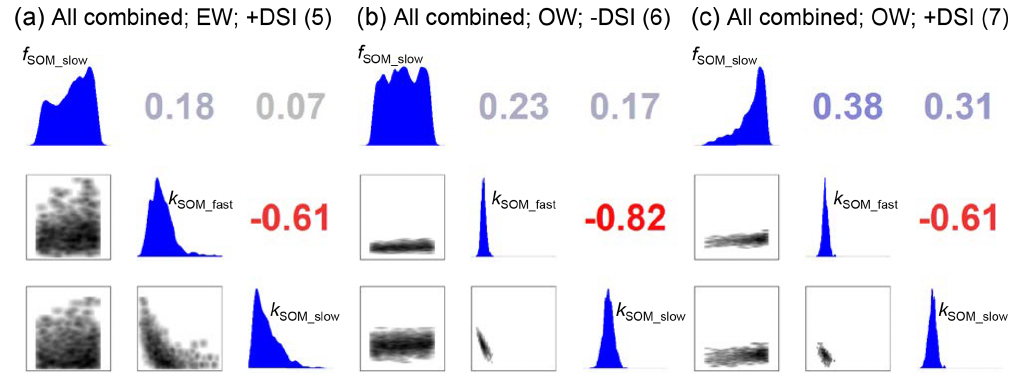
Figure 6. Correlation matrices of posterior distributions from the Bayesian calibrations of (a) equal weight calibration for all sites combined using the DSI (calibration 5), (b) original weight calibration for all sites combined without using the DSI (calibration 6) and (c) original weight calibration for all sites combined using the DSI (calibration 7). The plots of individual site simulations (calibrations 1–4) can be found in the